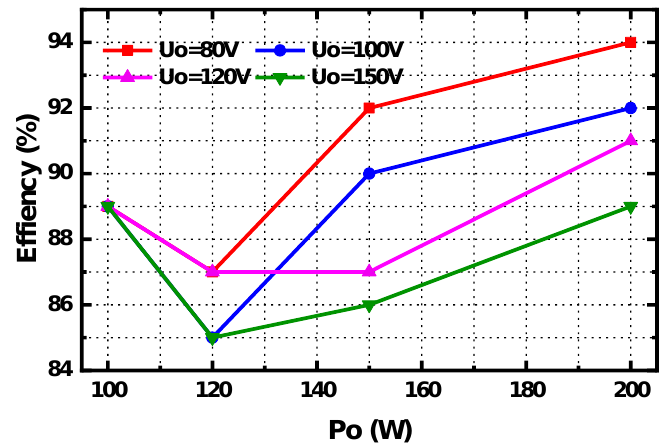
Figure 13. Efficiency curve of proposed